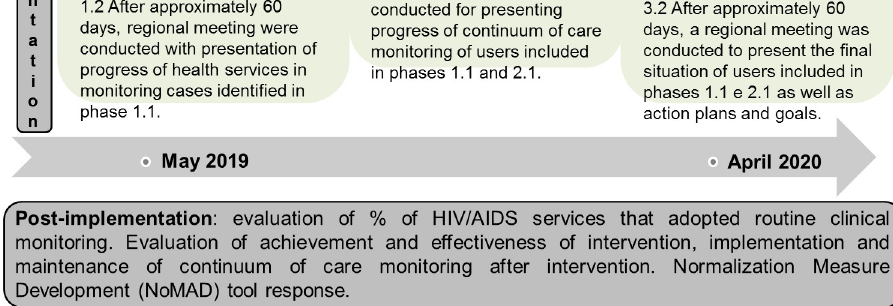
Fig 2. General structure of the intervention according to the steps of pre-implementation, implementation, and post-implementation of CCM.